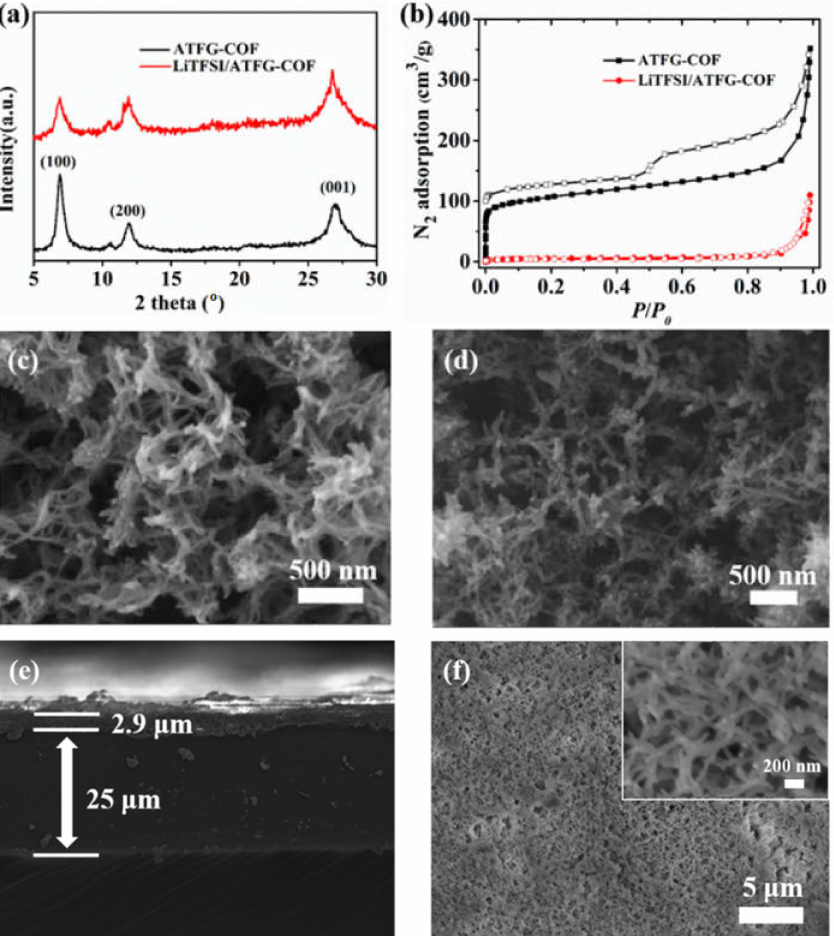
Figure 2. ( a ) XRD pattern and ( b ) N 2 adsorption of ATFG-COF and LiTFSI/ATFG-COF. SEM pictures of ( c ) ATFG-COF and ( d ) LiTFSI/ATFG-COF. SEM of ATFG-COF/PP: ( e ) Side view and ( f ) top